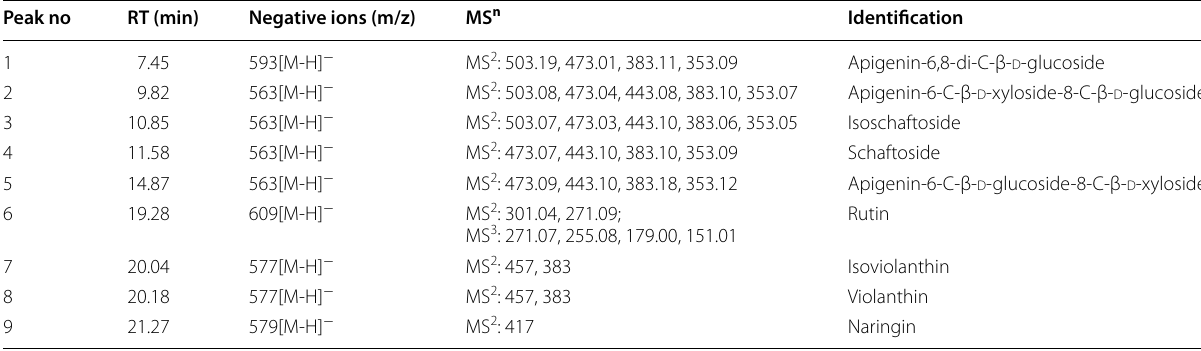
Table 1 MS date for characterization of compounds in Dendrobium officinale by UHPLC-ESI–MS/MS Peak no RT